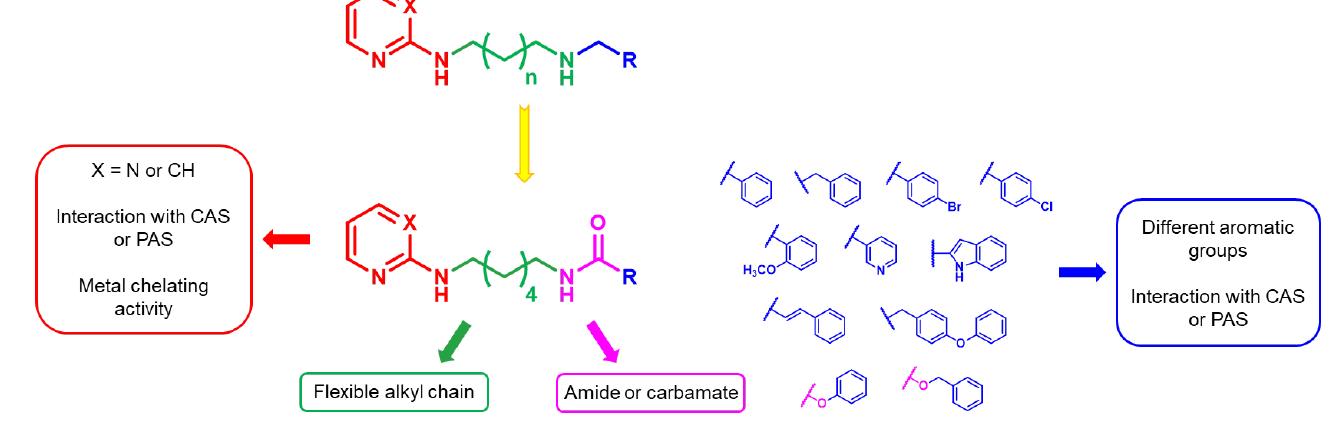
Figure 1. Rational design of the 2-amino-pyrimidine or 2-amino-pyridine amide or carbamate derivatives starting from diamine derivatives.